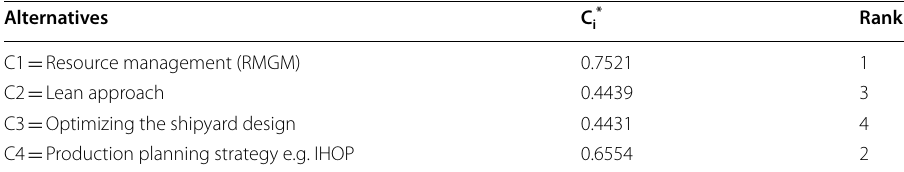
Table 22 Ranking of alternatives in operation criterion Alternatives C i*